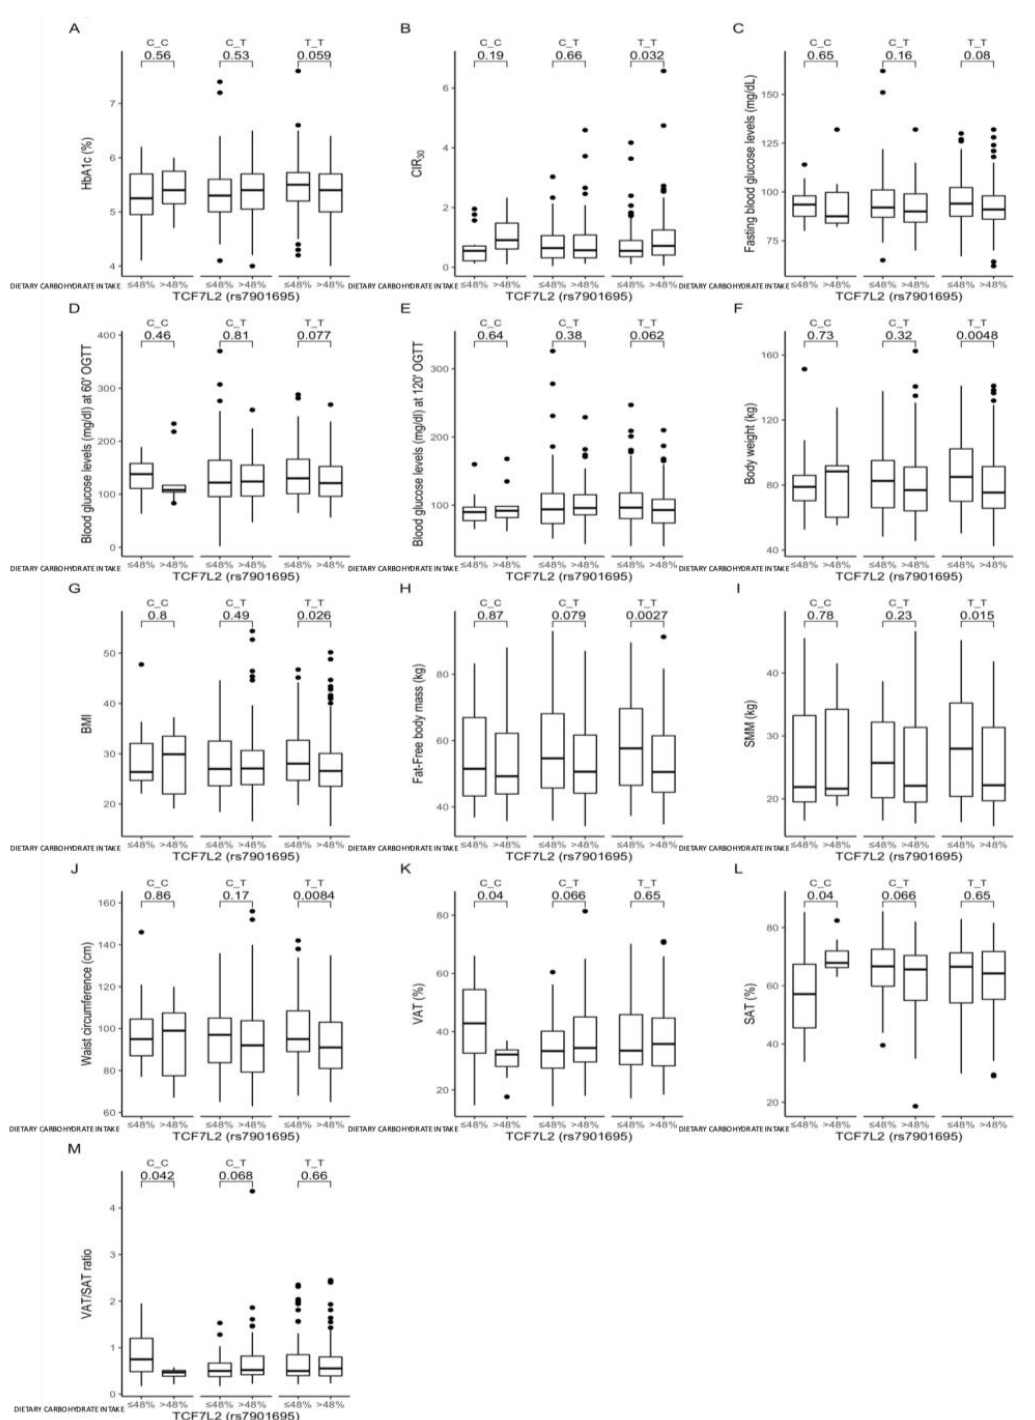
Figure 4. Association of dietary carbohydrate intakes ≤ 48% and >48% of total daily energy intake with ( A ) HbA1c, ( B ) CIR30, ( C ) fasting blood glucose levels (mg/dL), ( D ) blood glucose levels at 60 min of OGTT (mg/dL), ( E ) blood glucose levels at 120 min of OGTT (mg/dL), ( F ) body weight (kg), ( G ) BMI (kg/m 2 ), ( H ) FFM (kg), ( I ) SMM (kg), ( J ) waist circumference (cm), ( K ) VAT (%), ( L ) SAT (%), and ( M ) VAT/SAT ratio, in the TCF7L2 rs7901695 genotype carriers. The differences in median values of the selected responses and the interquartile ranges (IQRs) in different genotypic and dietary strata are presented.